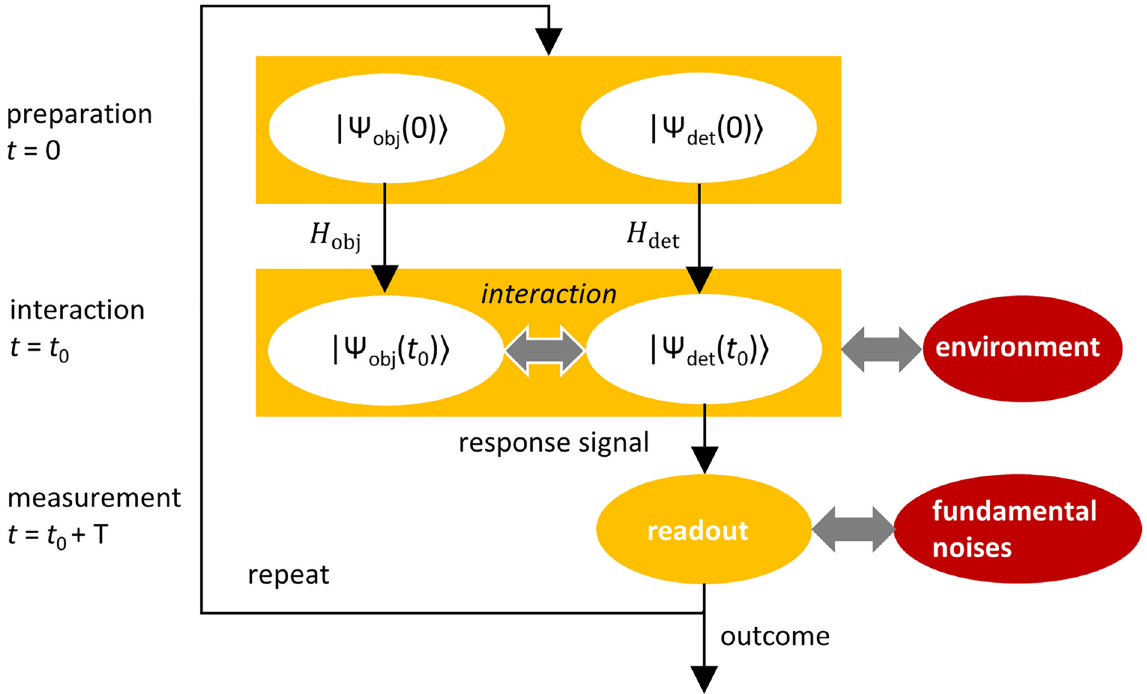
Figure 2: Quantum sensing process. Theobjectanddetectorareisolatedandinitializedintheknownstates | ψ obj (0) ⟩ and | ψ det (0) ⟩ ,respectively,at t =0.Then,thetwostatesevolve freelyforatimeduration t 0 andarriveatthepreparedstates Hamiltonians H obj and H det . Afterwards, the detector interacts with the object for a duration T . The inevitable environmental fl uctuations interrupt the coherent object – detector interaction. Finally, the response signal produced by the detector is measured by a readout device, whose sensitivity is fundamentally limited by quantum mechanics. The sensing process needs to be performed repeatedly to obtain the expectation value of the associated physical observable. Adapted from the study by Vollmer and Yu